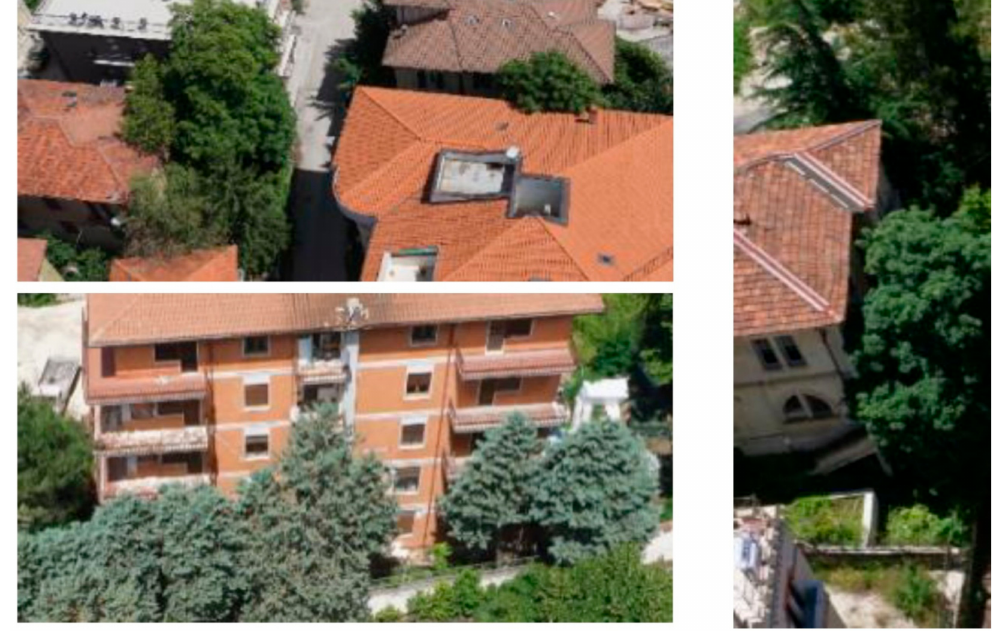
Figure 2. Typical problems for image processing posed by shadow and occlusion